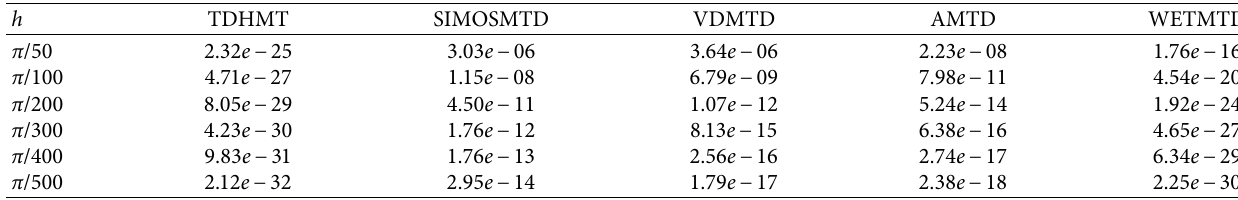
Table 10: Comparison of the absolute errors at the end point of TDHMT with absolute error of other existing methods, namely, SIMOSMTD, VDMTD, AMTD, and WETMTD for Example 2.